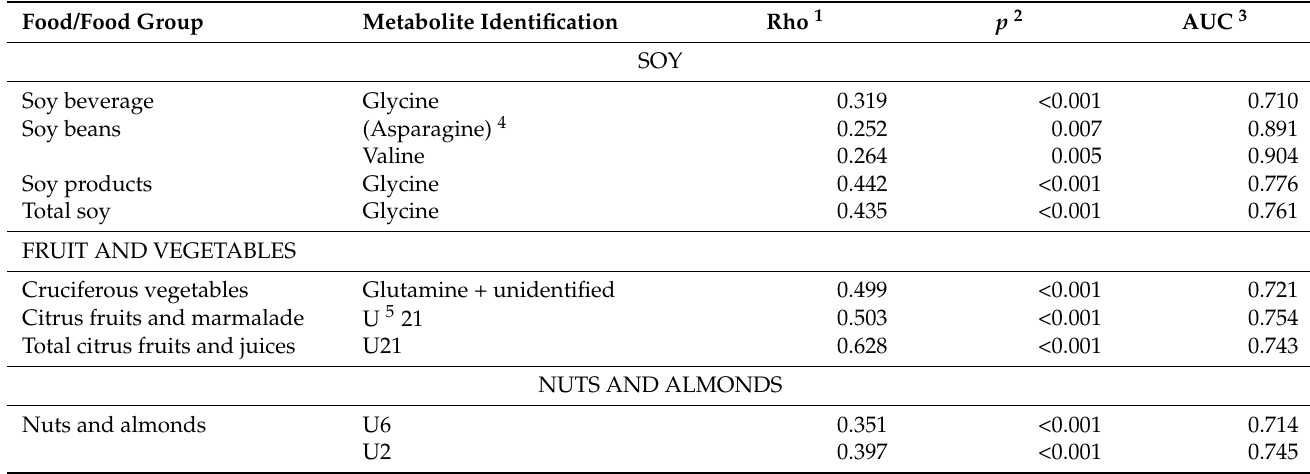
Table 1. Serum metabolites associated with reported food intake among healthy Swedish subjects ( n =